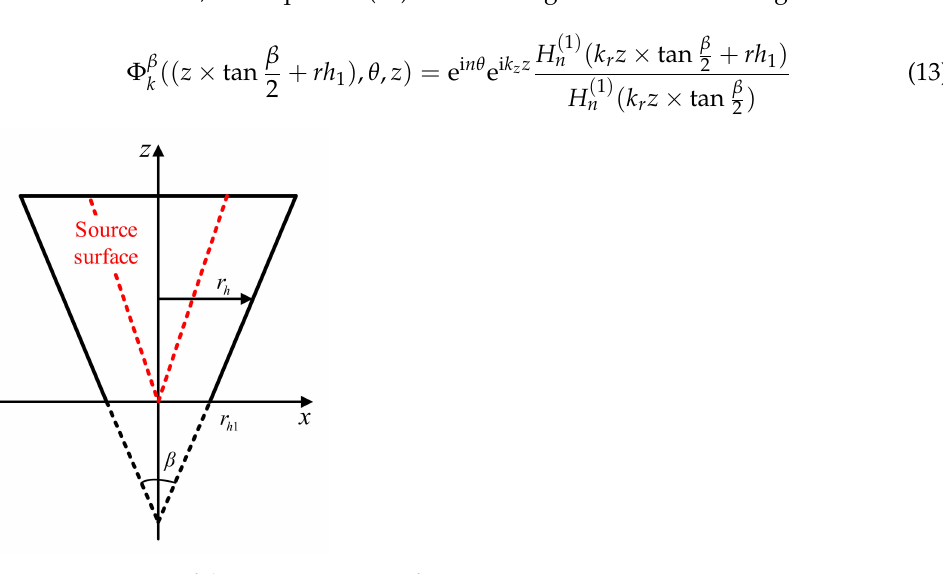
Figure 3. Front view of the measurement